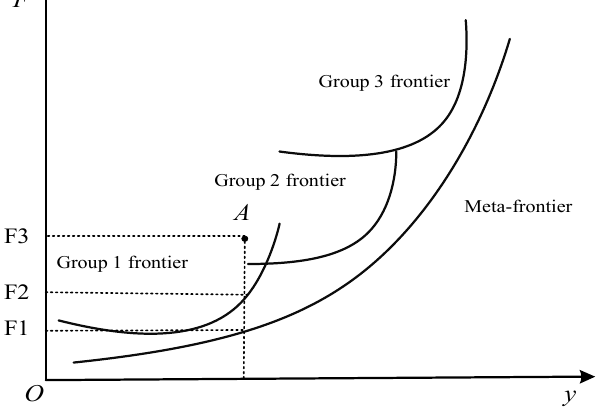
Figure 2. Illustration of the relationship between the meta-frontier and the groups’ frontiers.